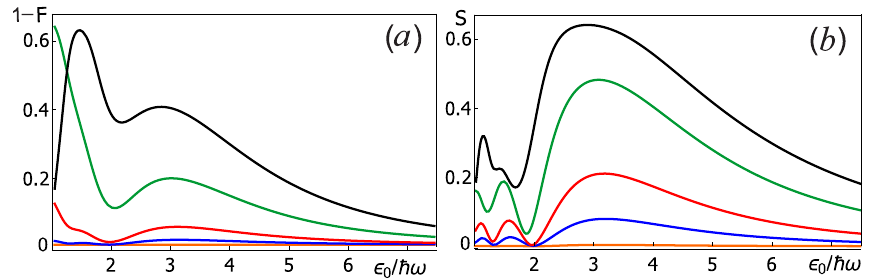
Figure 5. The infidelity ( a ) and the von Neumann entropy ( b ) of the system at the end of the Rabi pulse as a function of the amplitude of the qubit control field (cid:101) 0 for various occupation numbers of the measuring oscillator initial state n : 0 (orange), 5 (blue), 10 (red), 20 (green), and 30 (black). Other parameters of the system are determined by the relations